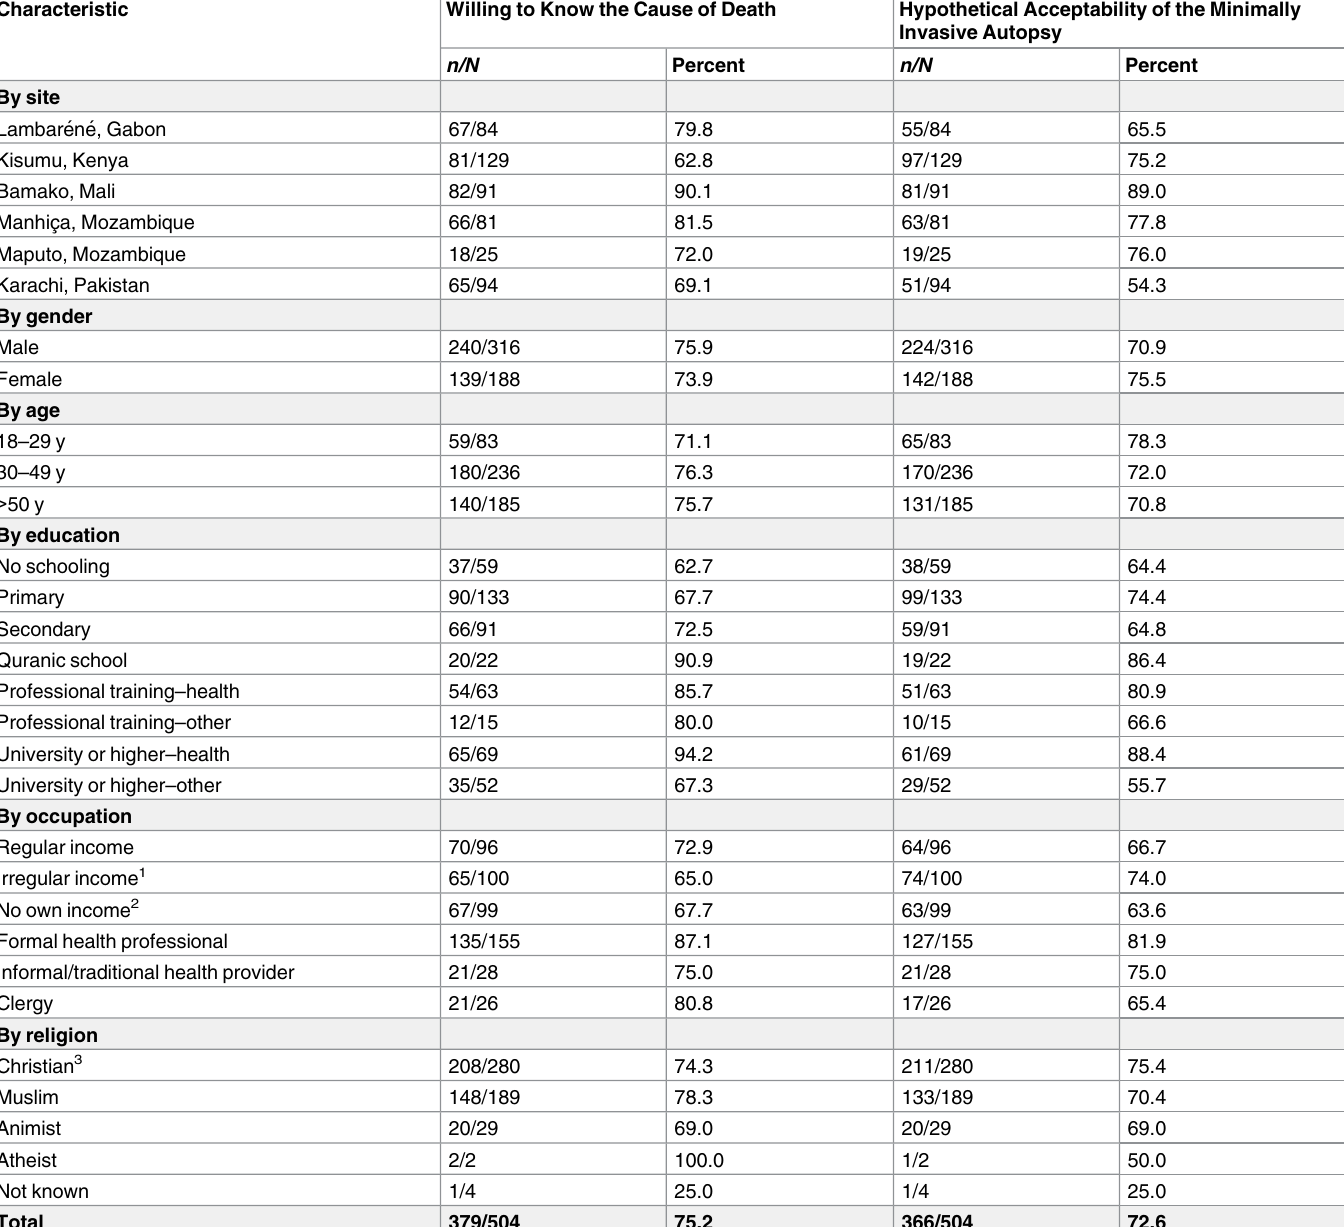
Table 3. Willingness to know the cause of death of a relative and hypothetical acceptability of the minimally invasive autopsy for a deceased rela- tive, according to site and interviewed participants’ socio-demographic characteristics.